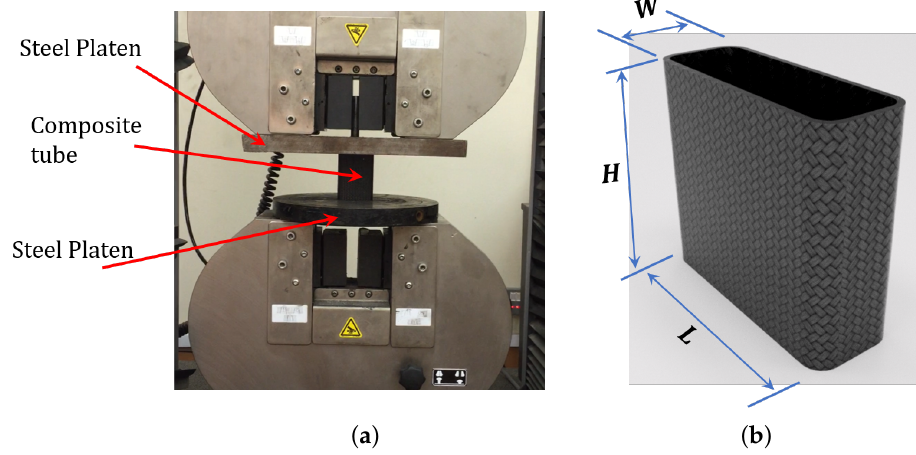
Figure 1. Test setup ( a ) and composite tube details ( b ) of the axial crushing tests.